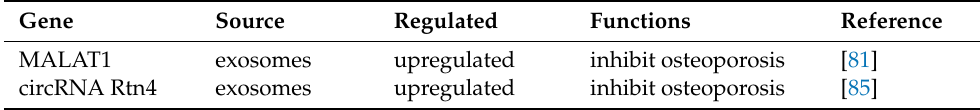
Table 4. The role of EV-associated lncRNA and circRNA in osteoporosis. Gene Source Regulated Functions Reference MALAT1 exosomes upregulated inhibit osteoporosis [81] circRNA Rtn4 exosomes upregulated inhibit osteoporosis